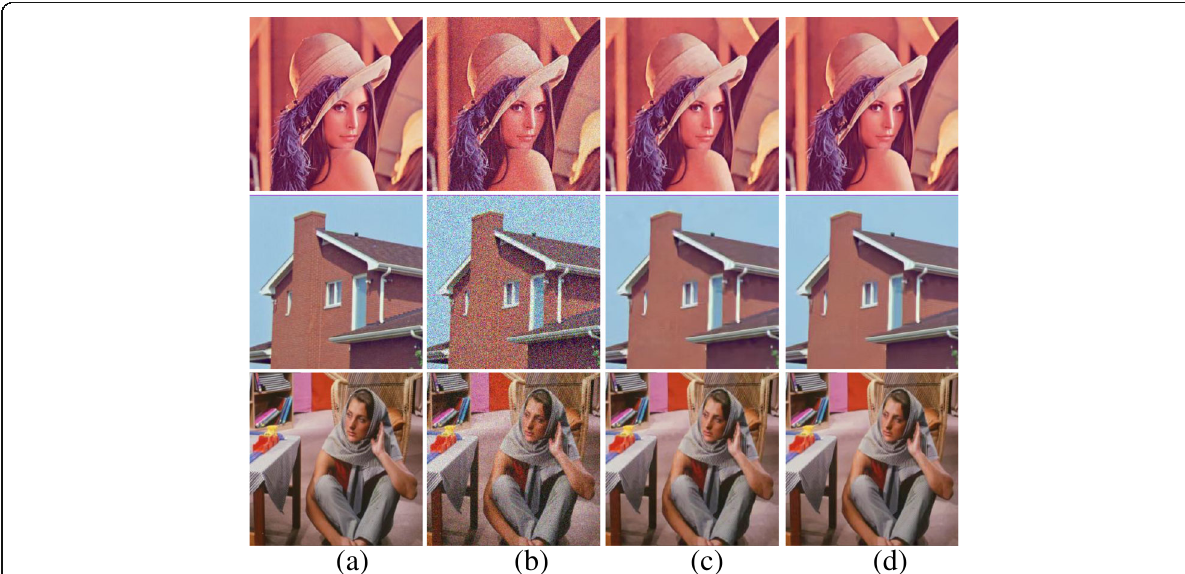
Fig. 8 The denoised results comparison of color Lena and House images between BM3D and SA-BM1-3D ( σ = 35). a Original images, b noisy images, c denoised images by BM3D, and d denoised images by